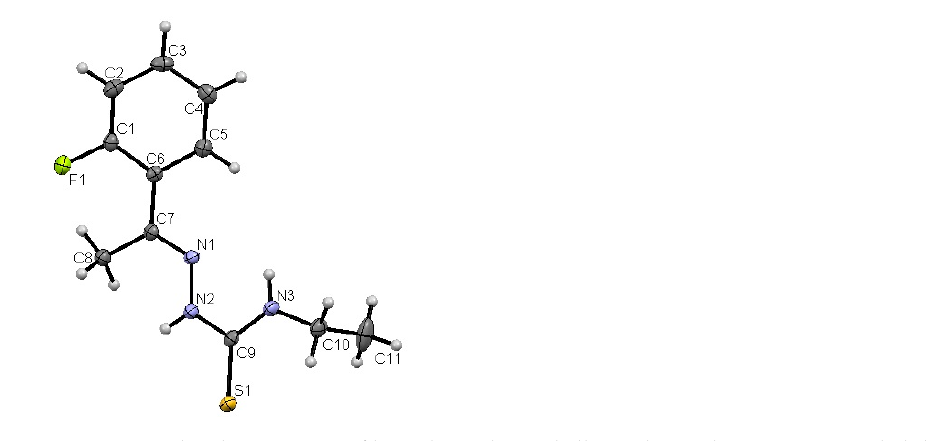
Figure 1. Molecular structure of ligand 3a . Thermal ellipsoids are shown at 50% probability level.